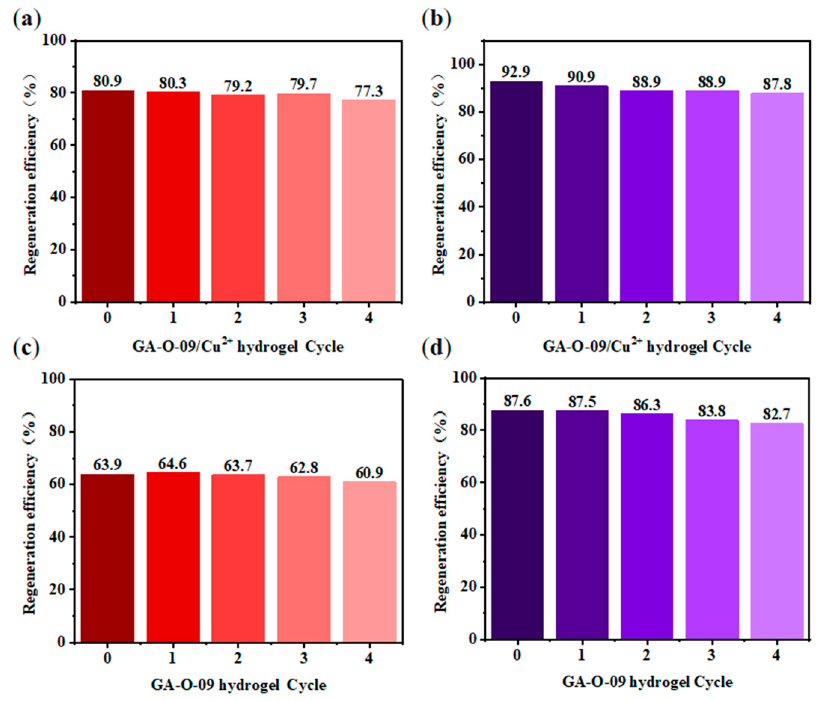
Figure 7. Regeneration cycles of ( a , c ) GA-O-09/Cu 2+ hydrogel and ( b , d ) GA-O-09 hydrogel after the adsorption of MO (red) and MC (purple) by washing with ethyl acetate at 25 °C, respectively.